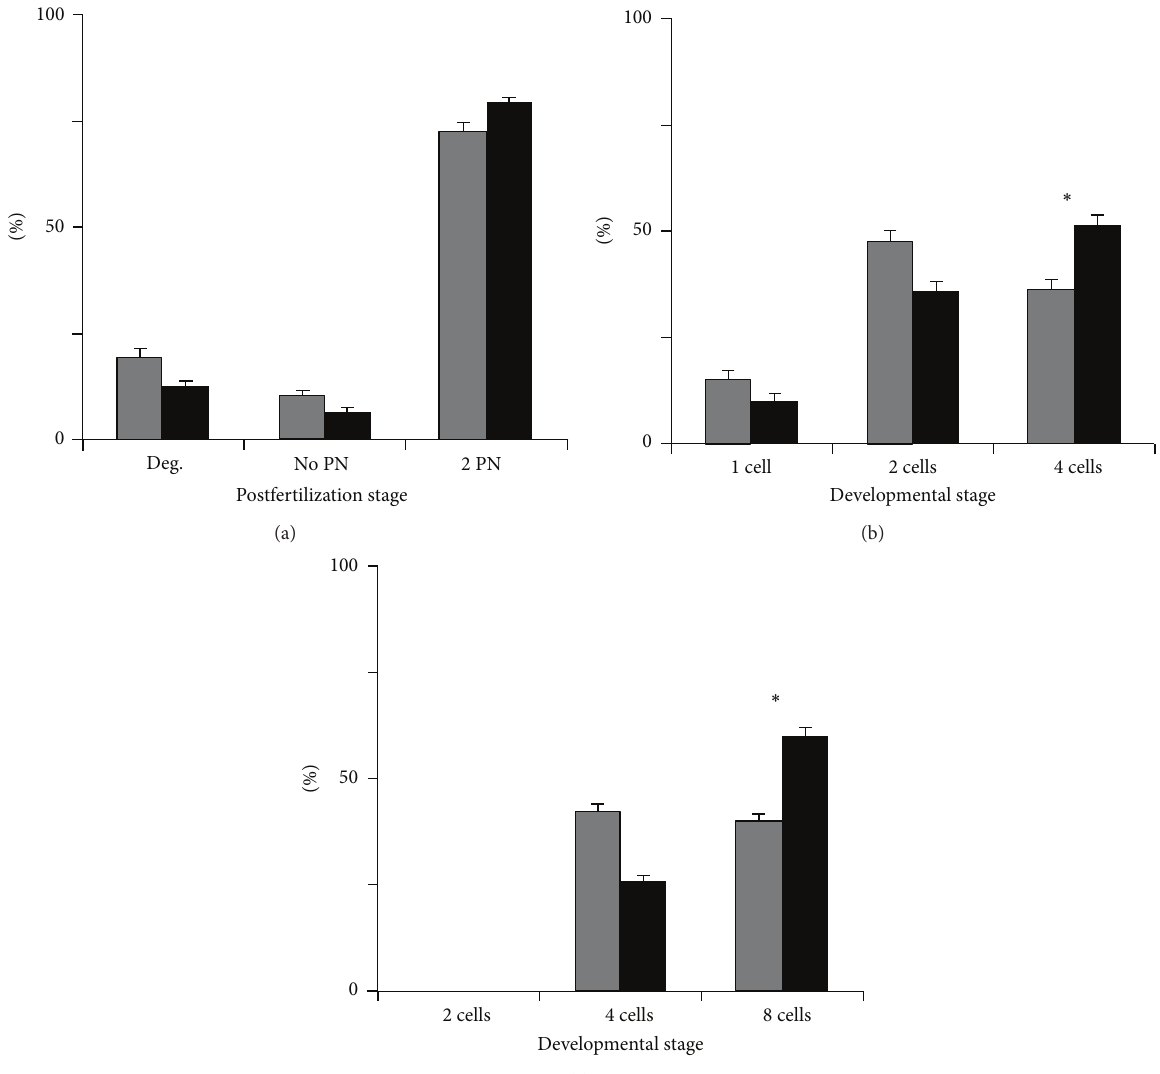
Figure 1: Effect of myo-inositol medium supplementation on pronuclear formation and embryo development during the first two days of in vitro culture. Completion of early developmental steps by zygotes cultured in the absence (grey bars) or the presence (solid bars) of 10mM myo-inositol. Zygotes were scored 6 hours (a) and embryos at 24–26 hours (b) and 48–50 hours (c) p.f. Bars represent the mean ± SEM of 7 independent experiments of the fraction of embryos at each indicated stage. (a) N, myo-Ins − embryos (grey bars), 121; myo-Ins+ embryos (solid bars), 123. ((b), (c)) N, myo-Ins − embryos (grey bars), 97; myo-Ins+ embryos (solid bars), 106. Asterisks indicate difference between treatments calculated by 𝜒 2 test with Yates correction for continuity: (b) 𝑃 < 0.05 ; (c) 𝑃 < 0.01